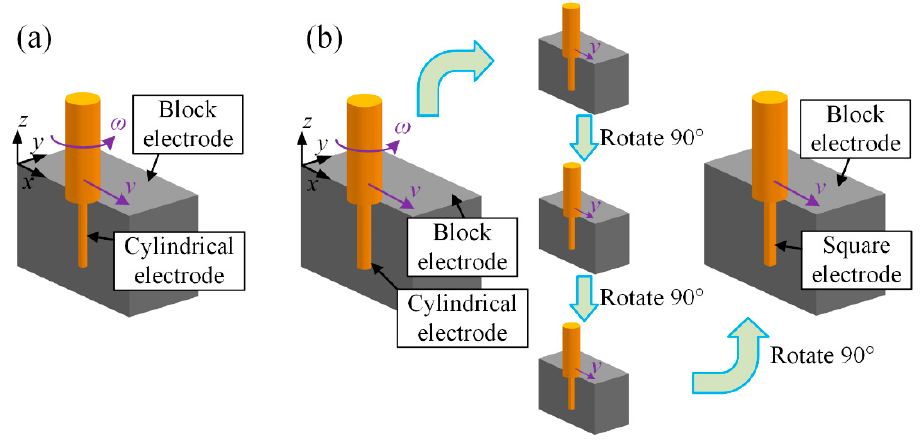
Figure 13. Schematic diagram of the in situ fabrication of the tool electrode: ( a ) cylindrical electrode and ( b ) square electrode.